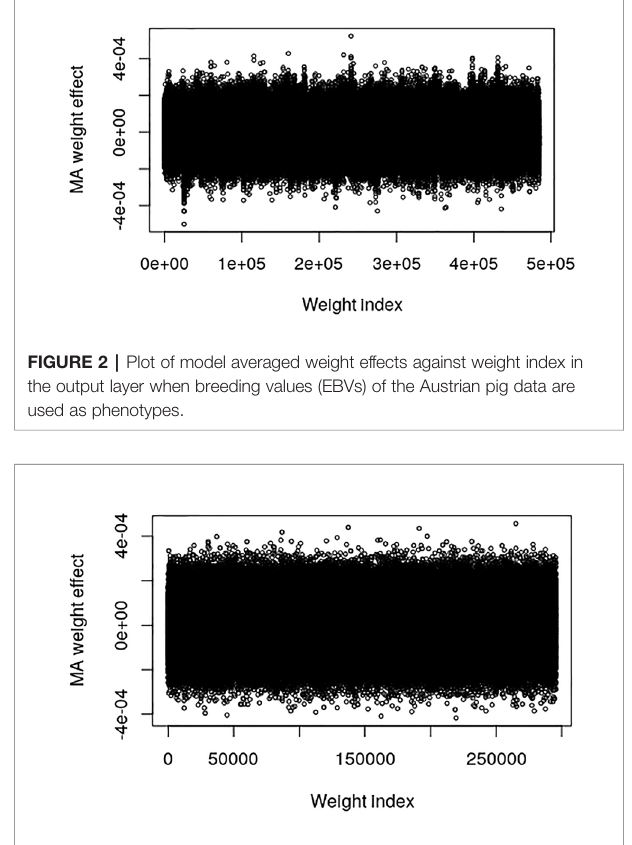
FIGURE 3 | Plot of model averaged weight effects against weight index in the output layer when number of live born piglet of the Austrian pig data are used as phenotypes.